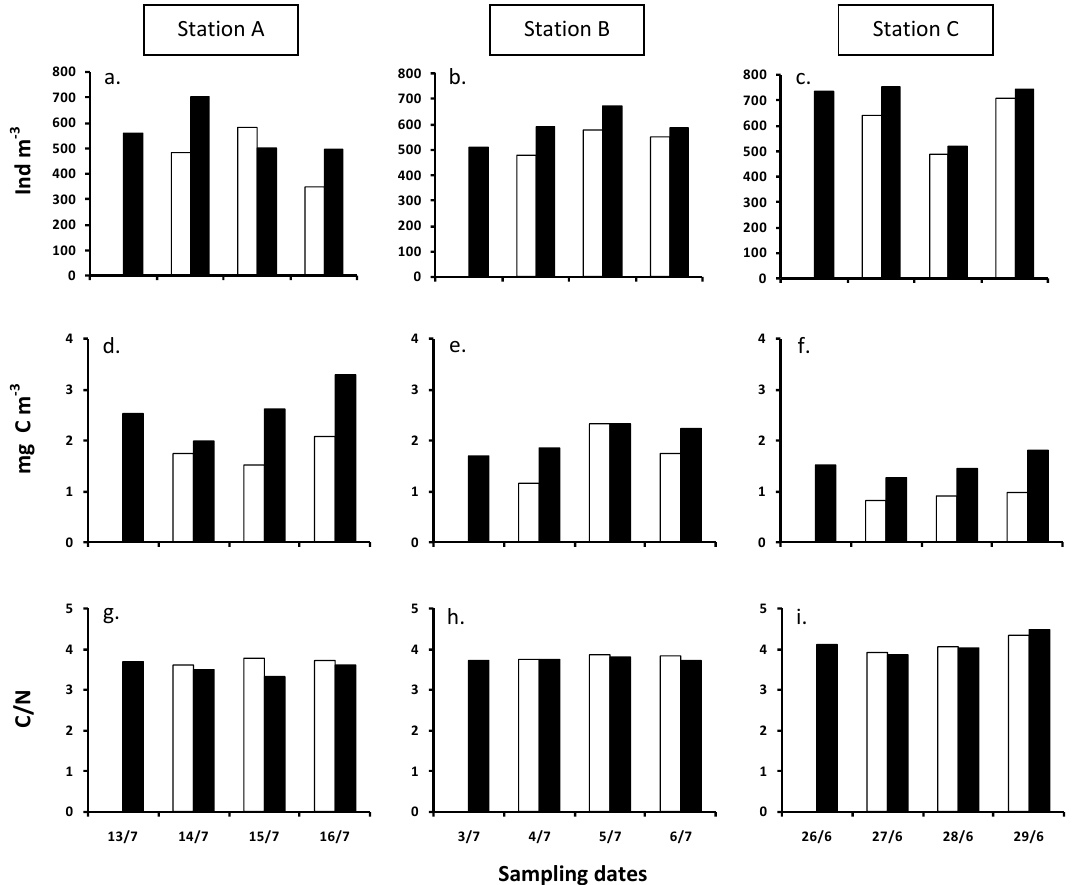
Fig. 7. Impact of sampling time (day: white; night: black) on zooplankton abundance integrated in the upper 200 m (ZooScan counts) (a, b, c), carbon biomass (d, e, f) and C/N ratio (g, h, i) at stations A, B and C.